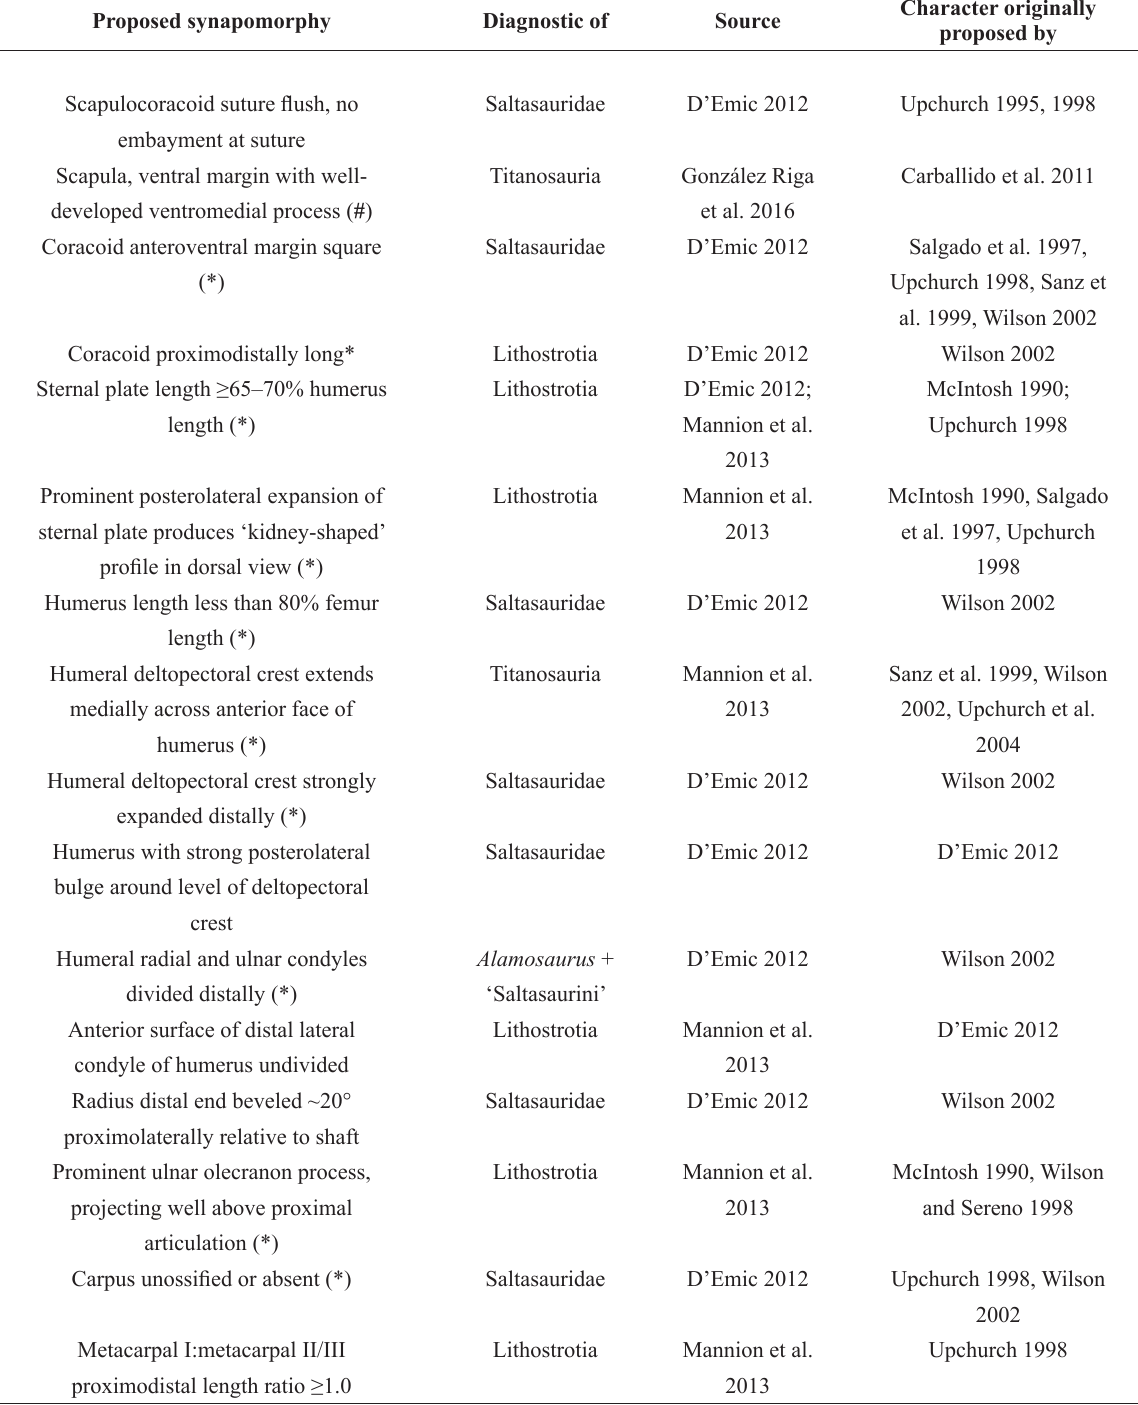
Proposed synapomorphies of the appendicular skeleton within Titanosauria and some of its subclades according to selected recent works (D’Emic 2012, Mannion et al. 2013, González Riga et al. 2016). Synapomorphies are ordered by anatomical region. (*) Description of synapomorphy modified from original source; (#) synapomorphy obtained from a published phylogenetic analysis but not explicitly mentioned